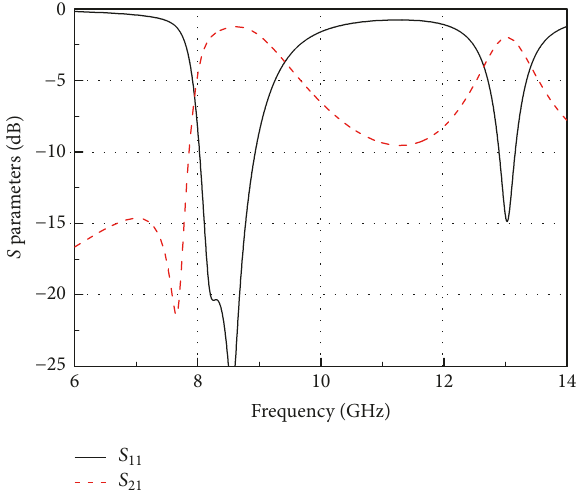
Figure 11: Simulated 𝑆 parameters of the DB LHM.